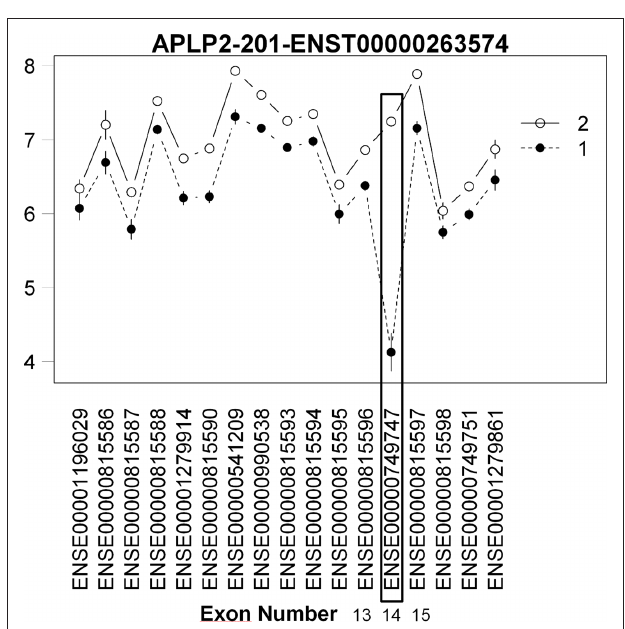
FiguRe 7 | Plot of brain specific Aeu event in human tissue dataset. Interaction plot of brain specific AEU event in human tissue dataset. Note that expression in exon 14 is large for group 2 (brain) while for heart (group 1), the expression is much lower. This cassette exon event has been confirmed by RT-PCR in Clark et al.’s (2007)